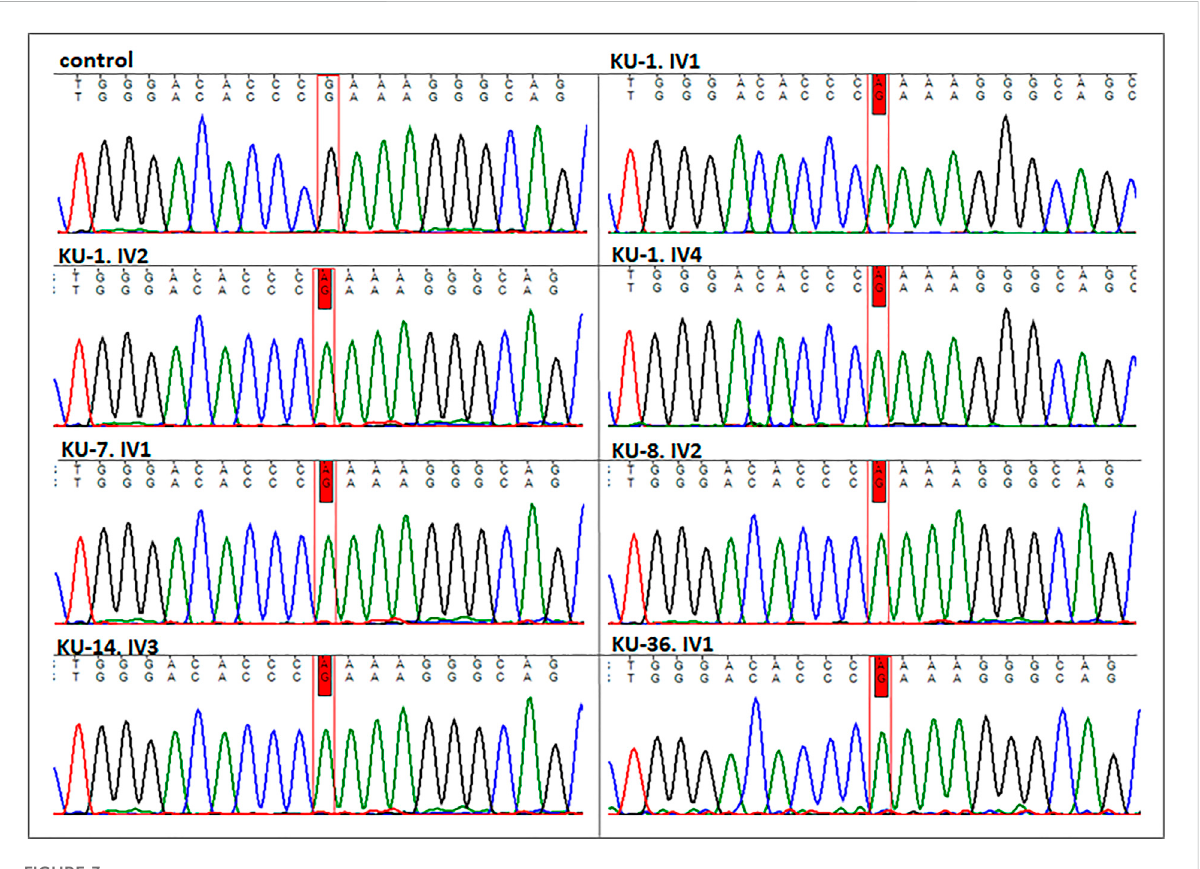
FIGURE 3 Sequencing chromatographs for the seven PCD individuals. All the patients having homozygous missense variant ( DNAI2 :c.740 G > A; p.Arg247Gln) rs755060592 in exon 7 as illustrated vs. heathy individual as